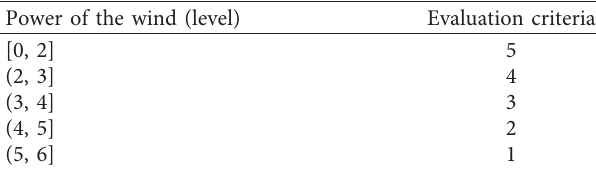
Table 4: Numerical table of wind power